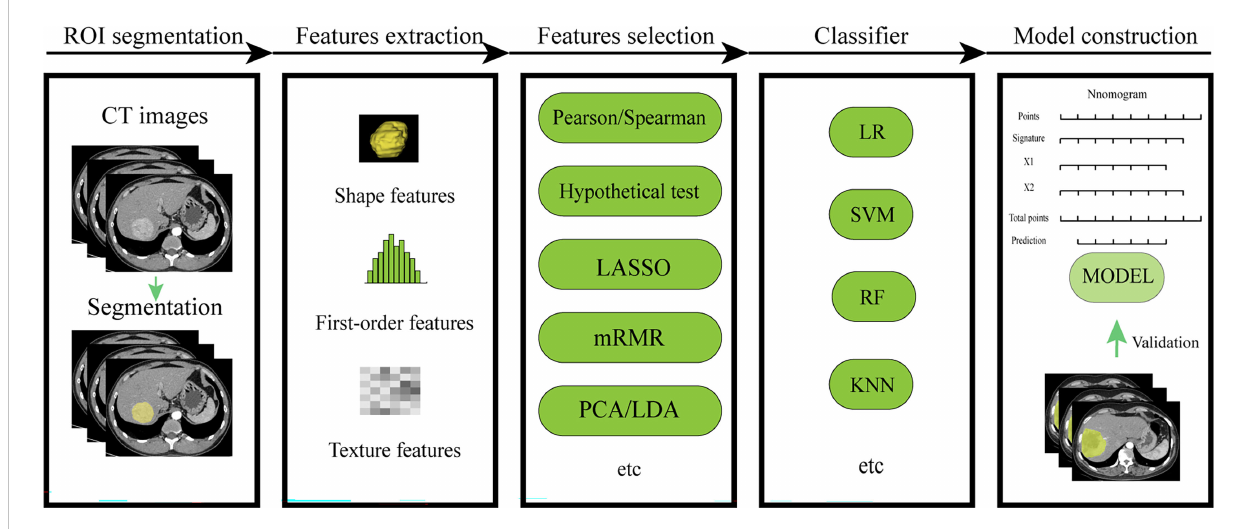
FIGURE 2 Work fl ow of conventional radiomics. LASSO, least absolute shrinkage and selection operator; mRMR, maximal relevance and minimal redundancy; PCA, principal components analysis;LDA, linear discriminant analysis; LR, logistic regression; SVM, support vector machine; RF, random forest; KNN, k-nearest